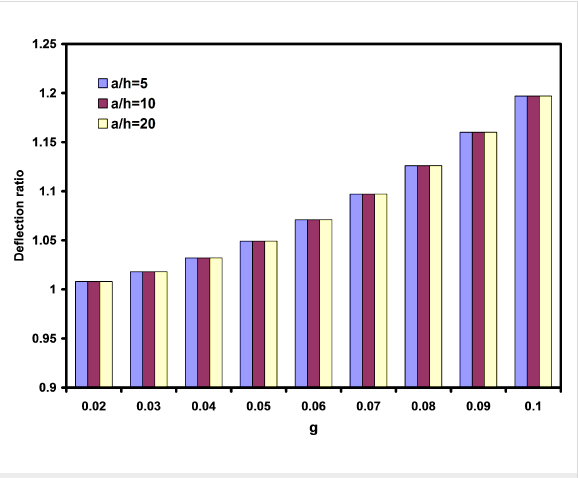
Figure 5: The effects of nonlocal parameter and length to thickness ratio on the deflection ratios.